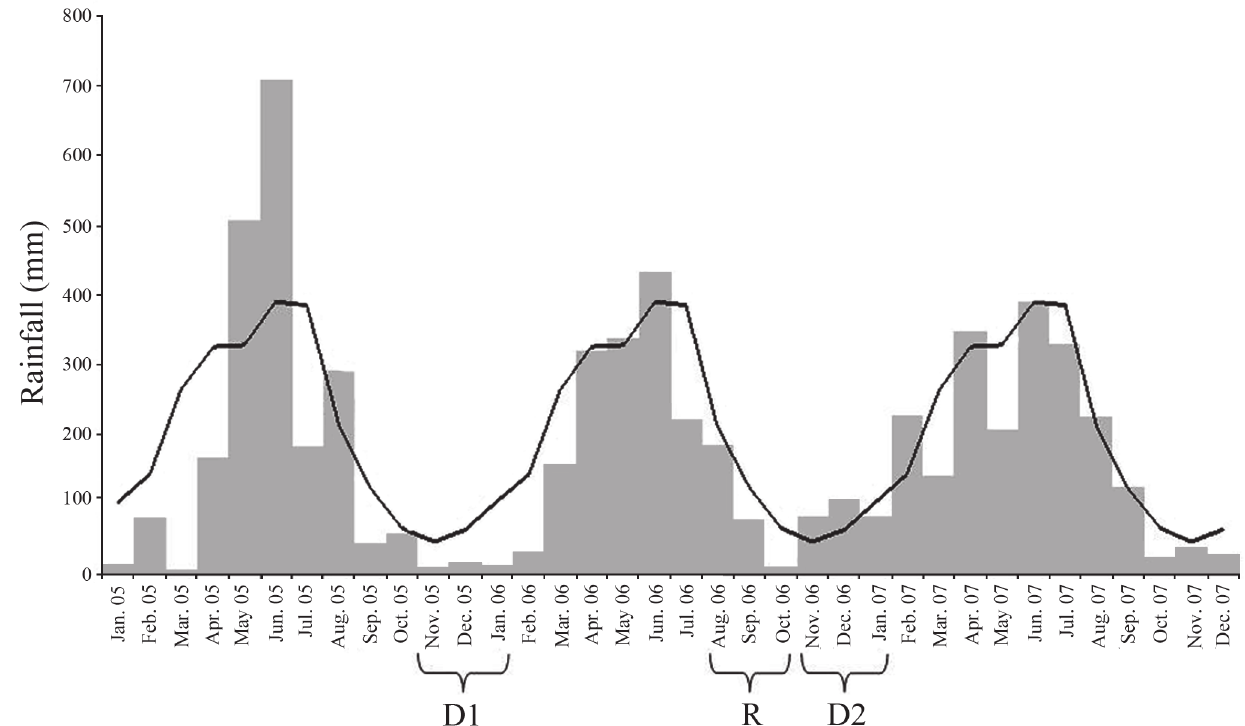
Fig. 2. Rainfall in the study area from a historic (1961 to 1990) data set (solid line) and from 2005-2007 (bars). Source: http:// www.inmet.gov.br - meteorological station Recife-82.898).